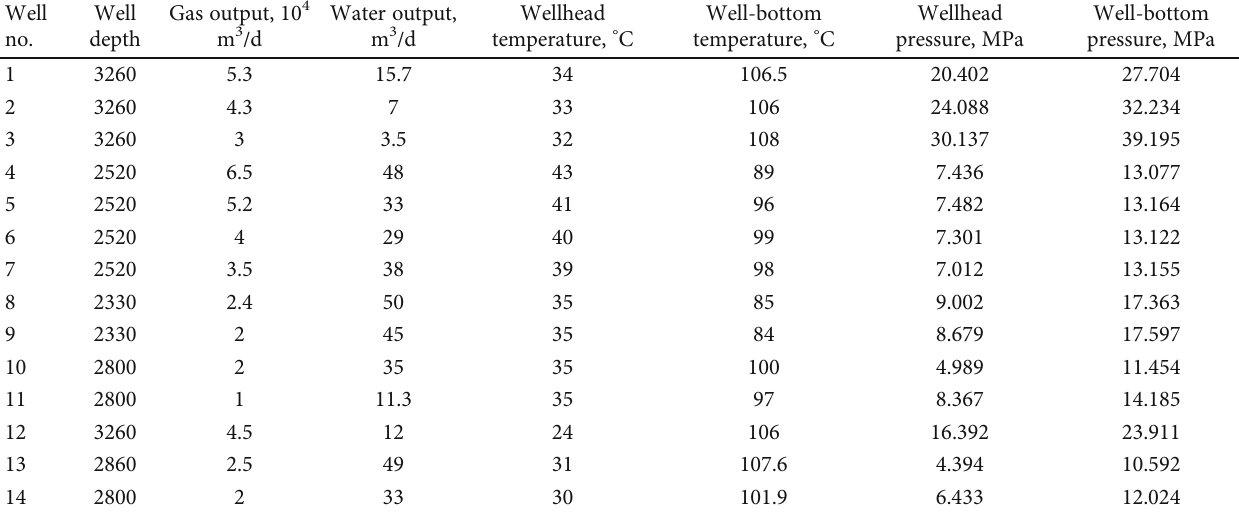
Table 1: Measured data in gas wells.